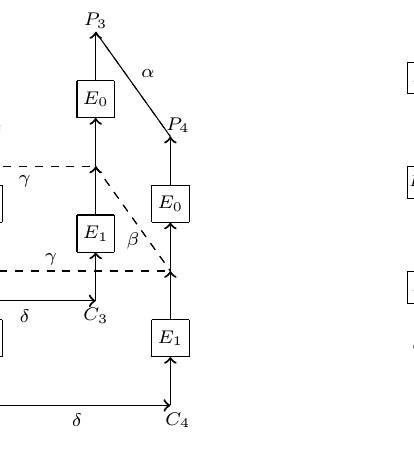
Figure 1: The boomerang attack Figure 2: The sandwich